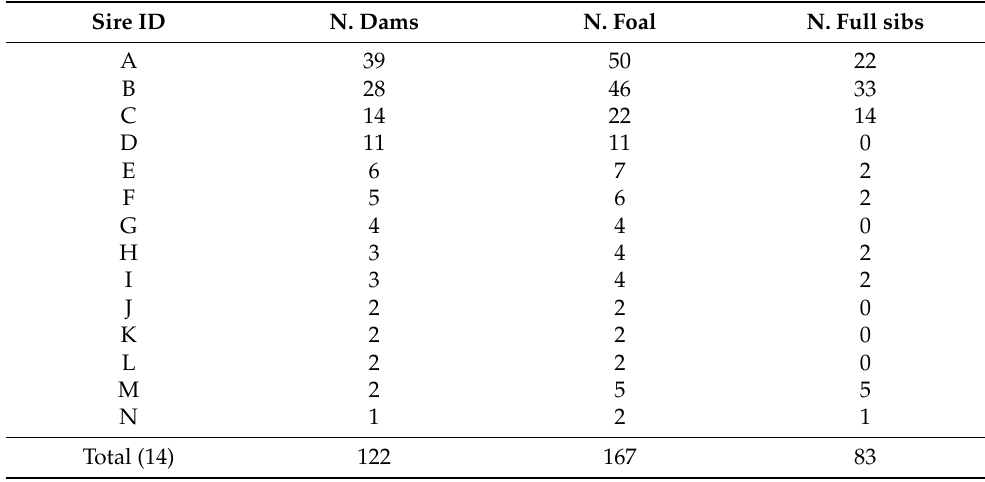
Table 5. The table reports the stallions fathers of foals in 2011–2019, number of their dams and foals, the latter categorized as full sibs. Eight foals born but not having sibs in the period were excluded. Sire ID N.